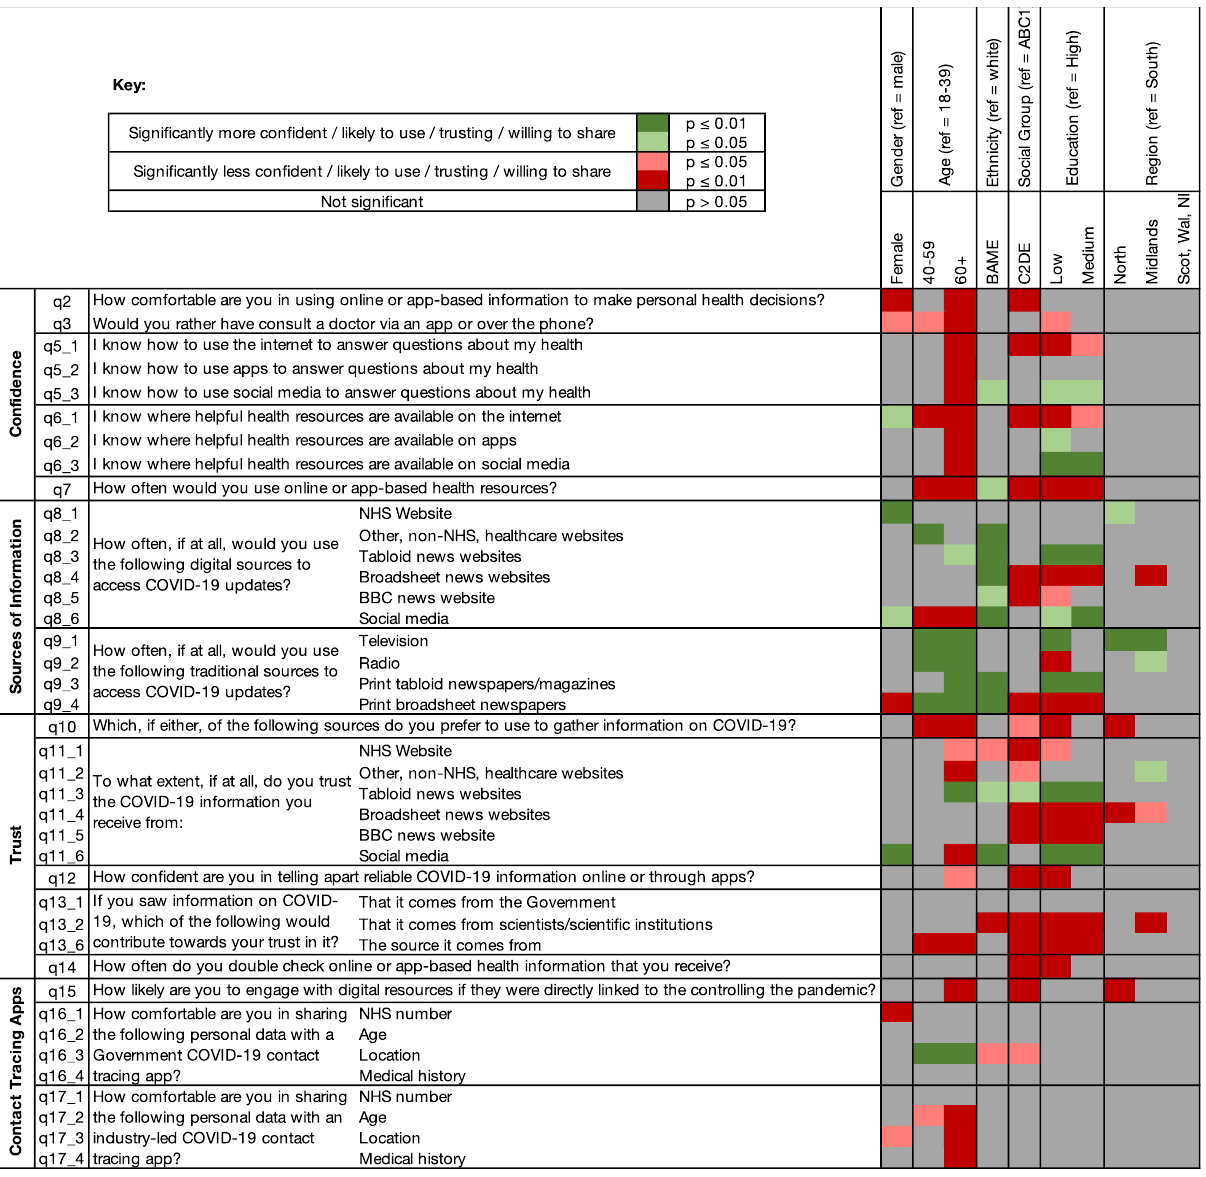
Figure 1. A significance map detailing directionality and significance of relationships between responses and the panel of demographic